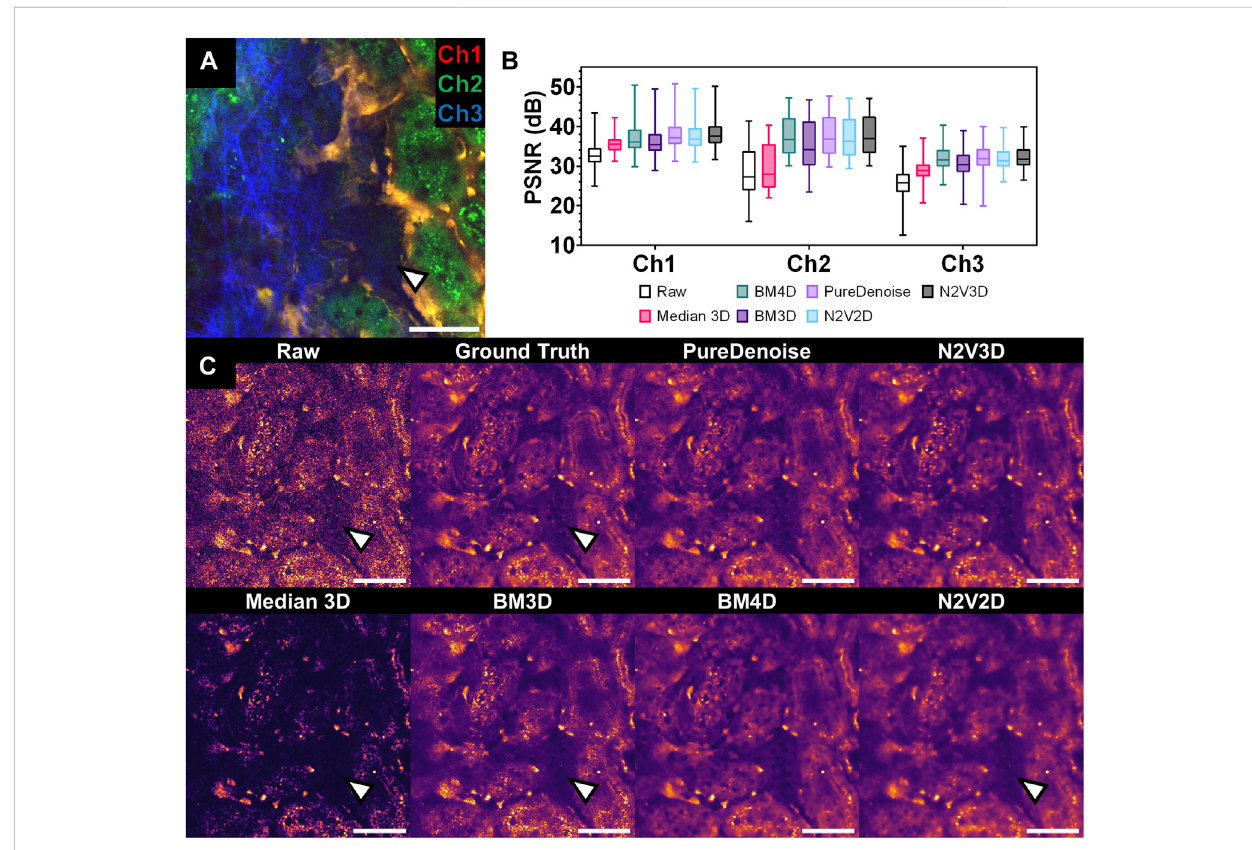
FIGURE 2 Performance of multiple denoising algorithms on an intravital 2-photon microscopy dataset corrupted by Poisson-Gaussian noise. (A) Composite intravital2-photonmicroscopyimageoffromvalidationdataset(Table1):Channel1(Ch1)showsendothelialcellsexpressingtdTomato(orange),channel 2 (Ch2) demonstrates renal tubular auto fl uorescence (green) and channel 3 (Ch3) depicts collagen fi brils in the capsule visualized through second harmonic generation (blue). Scale bar = 50 µm. (B) Quantitative assessment of denoising performance of multiple algorithms. Peak signal to noise ratio(PSNR)wasmeasuredforeachsliceanddetectionchannelinthevalidationdataset(n=1,125perchannel)forrawdata(Raw)anddifferentdenoising algorithms.Boxplotwithmedian,25thand75thpercentiles,andwhiskersforminimumandmaximumvalues.NotelowPSNRlevelsforMedian3D fi lterin Ch2 and 3 (statistical comparison in Table 2). (C) Qualitative assessment of denoising performance of multiple algorithms. Side-by-side comparison of single channel (Ch2) intravital 2-photon images displaying the same fi eld of view in raw data (raw), noise-free Ground Truth image (averaged from 25 noisy images of the same fi eld of view), and after denoising with different denoising algorithms. Note poor recovery of dark fl uorescent signals after denoising with Median 3D and 2D-based algorithms BM3D and N2V2D (arrowheads). Data is presented with a mpl-inferno lookup table depicting lower intensities in black and higher values are in light yellow. Scale bar = 50